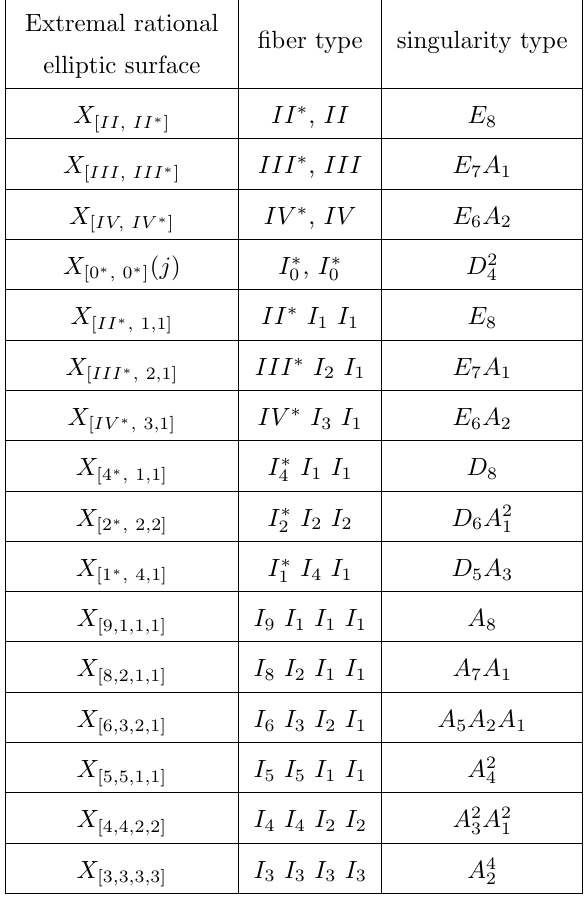
Table 6 . Fiber types of the extremal rational elliptic surfaces are listed. Open